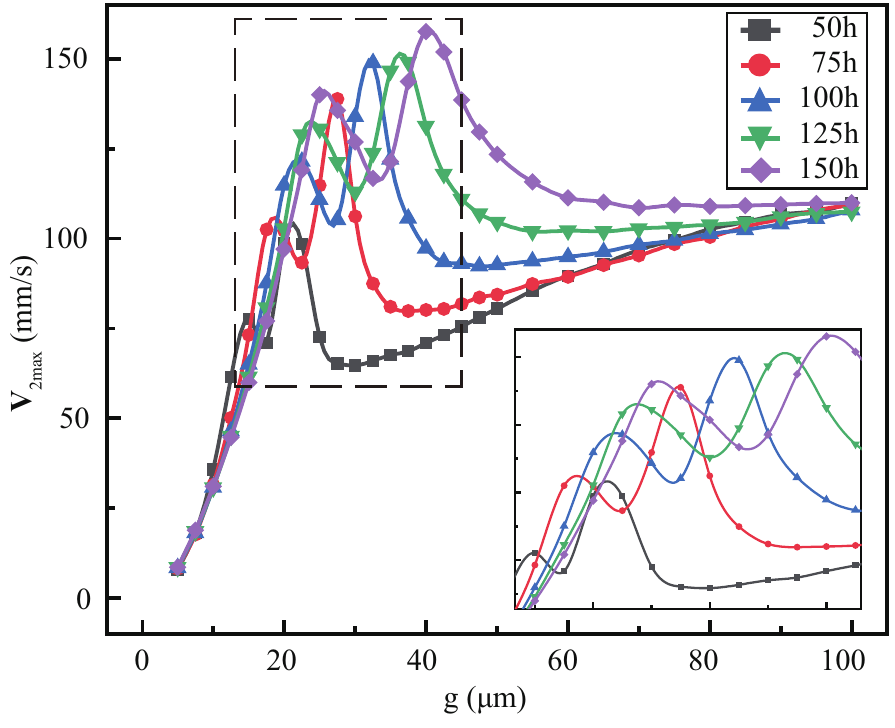
Figure A4. The effect of gap on maximum streaming velocity under five types of heights. Local amplification in the dotted line frame, see inset.